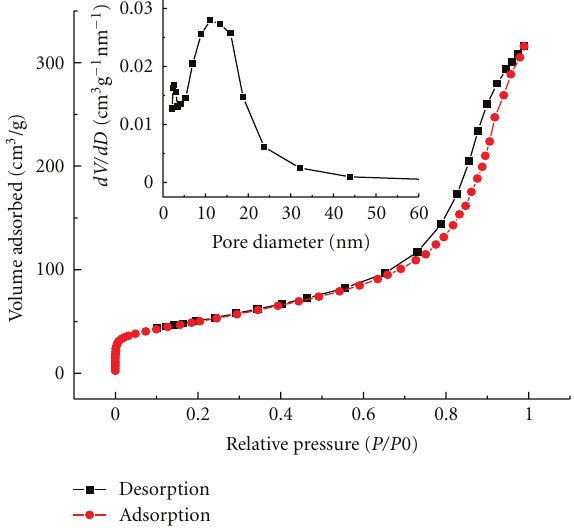
Figure 4: N 2 adsorption-desorption isotherm of the as-prepared mesoporous TiO 2 , and the inset is the BJH pore-size distribution